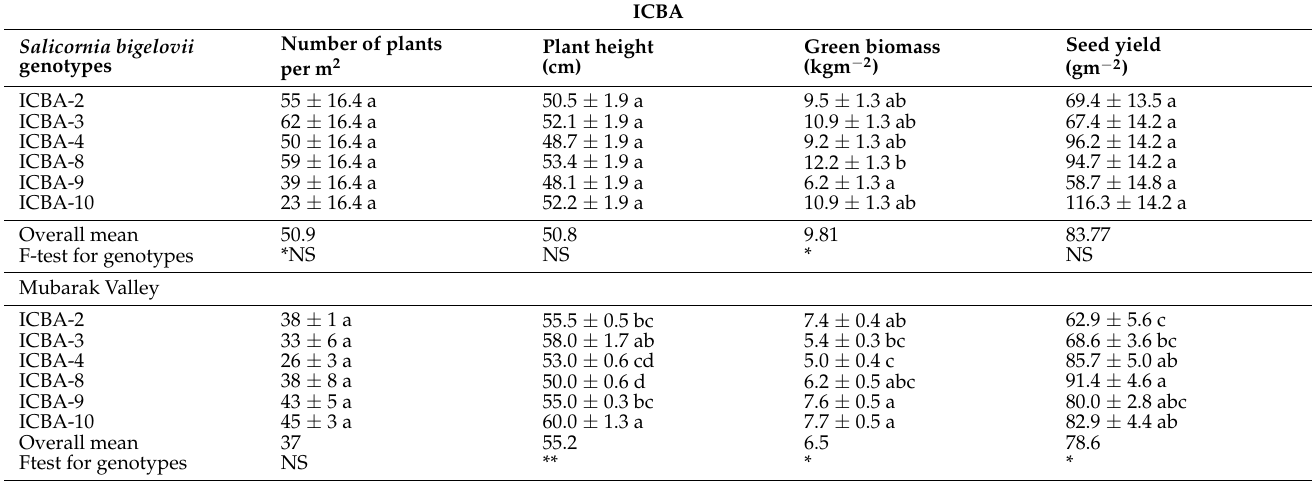
Table 6. Growth and yield parameters (mean values ± S.E.) of six Salicornia bigelovii genotypes evaluated at ICBA and Mubarak Valley. Values having the same letter are not significantly different ( p < 0.05, p < 0.001). LSD multiple comparison test was conducted per trait per location. ICBA